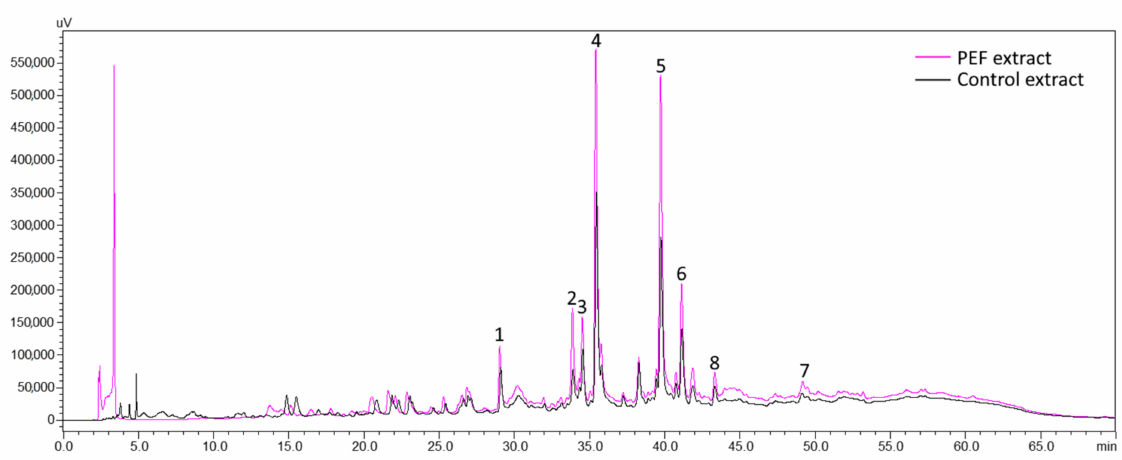
Figure 8. Overlay of chromatograms of PEF and control extracts with a pulse duration of 10 µ s and extraction solvent 25% EtOH. Peak 1: not identified, Peak 2: quercetin-3-O-rutinoside, Peak 3: not identified, Peak 4: luteolin-7-O-glucoside, Peak 5: apigenin-7-O-rutinoside, Peak 6: luteolin-3 (cid:48) -O-glucoside, Peak 7: not identified, Peak 8: